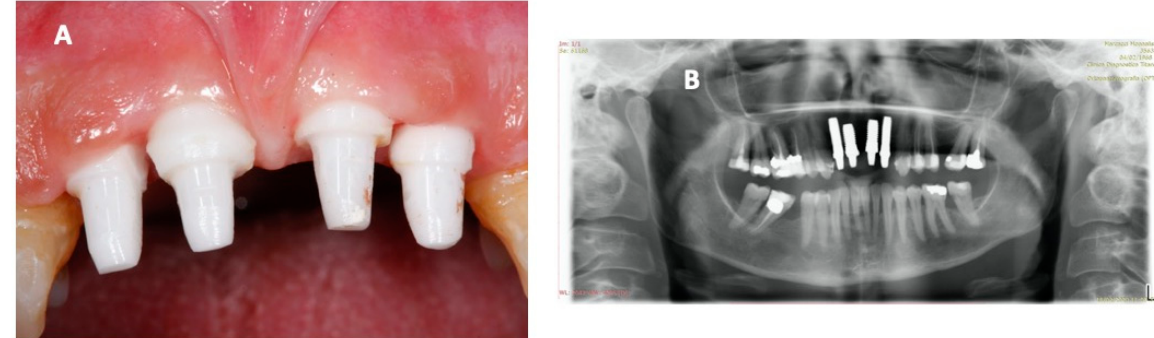
Figure 4. Pictures obtained six months after the operation, showing ( A ) a good state of osteointegration, no bleeding, and no active infection, with healthy periodontal tissue, and ( B ) dental radiography showing a good grade of osteointegration and no significant radiolucent areas.